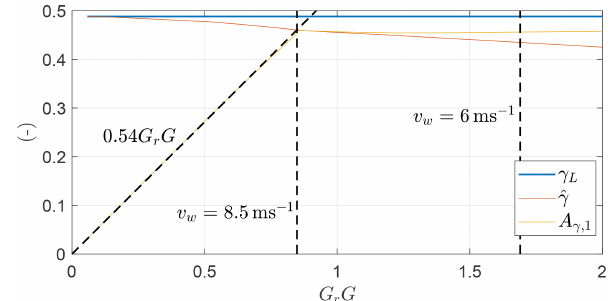
Figure 31. Optimal values of A β, 1 and A φ, 1 normalized with the analytical expression of the opening angle ˜ (cid:56) for a case with η el = 0 . 8 (–) and η el = 1 (– –) as a function of G r G